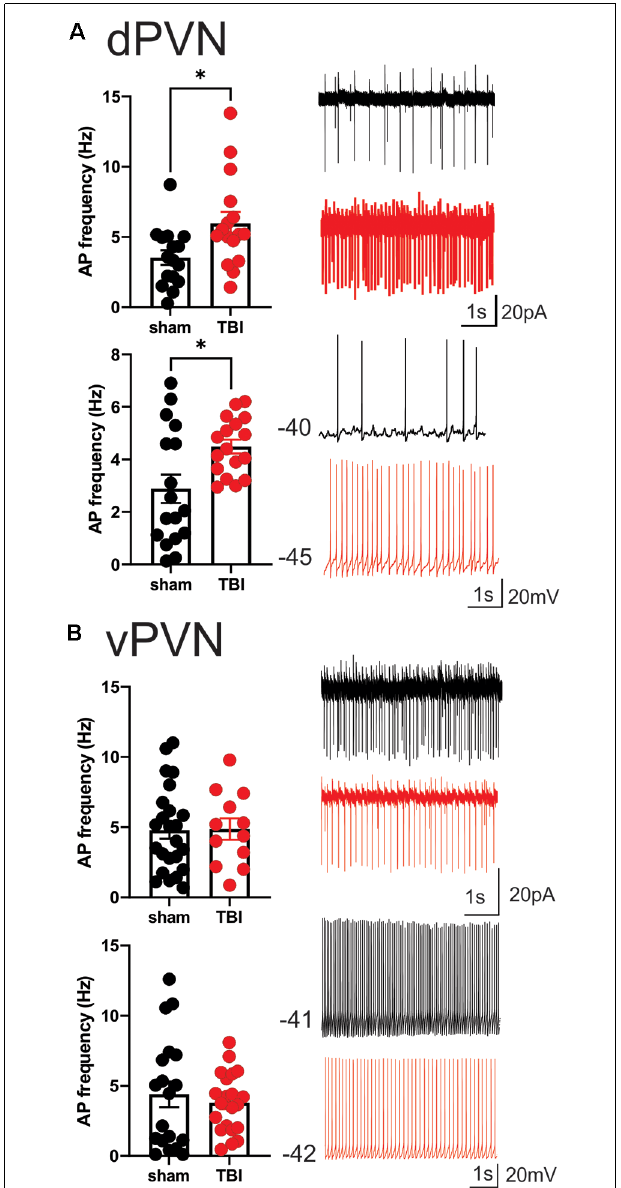
FIGURE 2 | mbTBI increases spontaneous activity of dPVN CRF neurons. Representative traces, and comparison of action potential (AP) frequency under voltage-clamp (top, V = 0) cell-attached recordings and current clamp (bottom, I = 0) whole-cell recordings across sham (black) and mTBI (red) mice in (A) dPVN and (B) vPVN CRF neurons. n = 12–24/5/Group. Unpaired Student’s t -test, ∗ p < 0.05.